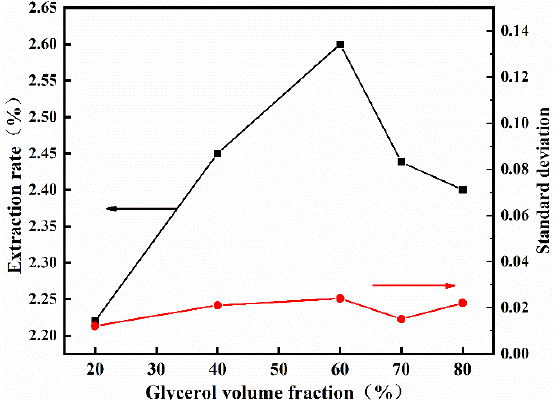
Figure 4. Effect of glycerol volume fraction on extraction yield. ( The black arrow represents the extraction rate curve and the red arrow represents the standard deviation curve. )